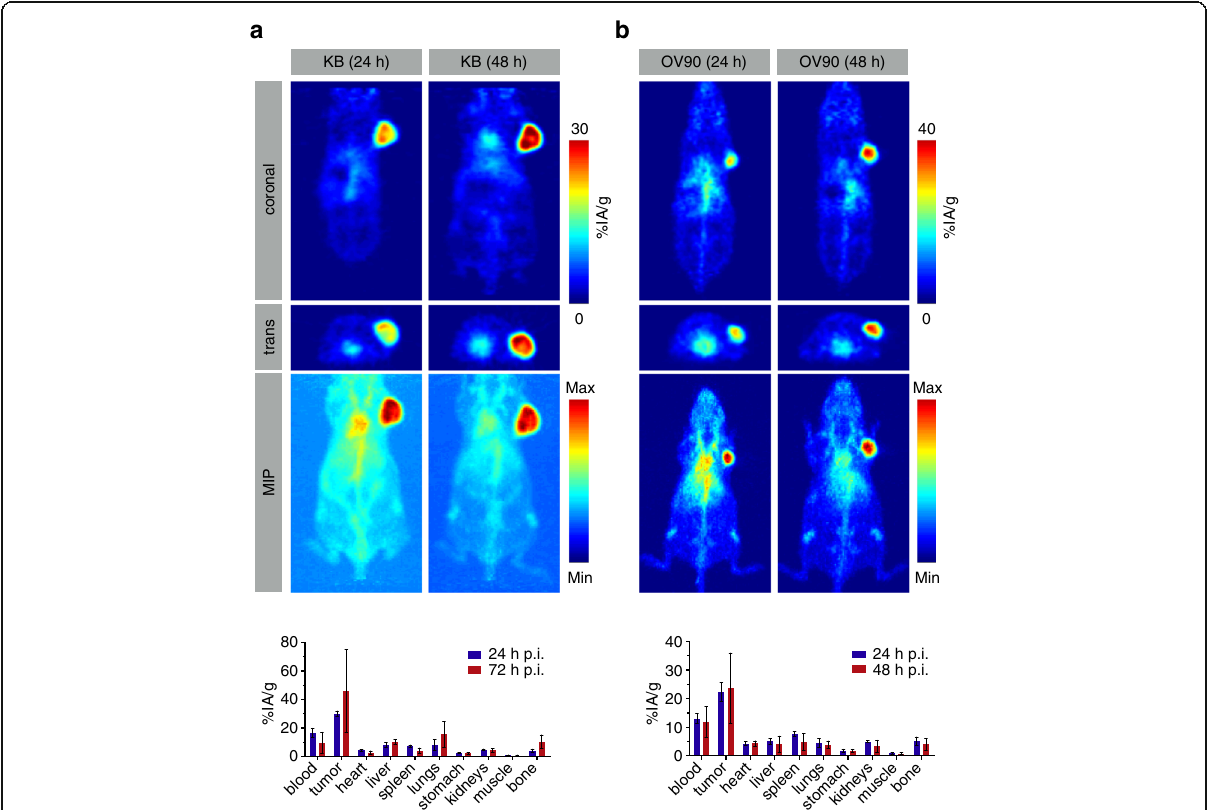
Fig. 3 In vivo studies of [ 89 Zr]Zr-DFO-M9346A: a PET images acquired at 24 h and 48 h post-injection and biodistribution studies performed at 24 h and 72 h with [ 89 Zr]Zr-DFO-M9346A intravenously administered in KB tumor bearing mice. b PET images acquired at 24 h and 48 h post- injection and biodistribution studies performed at 24 h and 72 h with [ 89 Zr]Zr-DFO-M9346A intravenously administered in tumor bearing